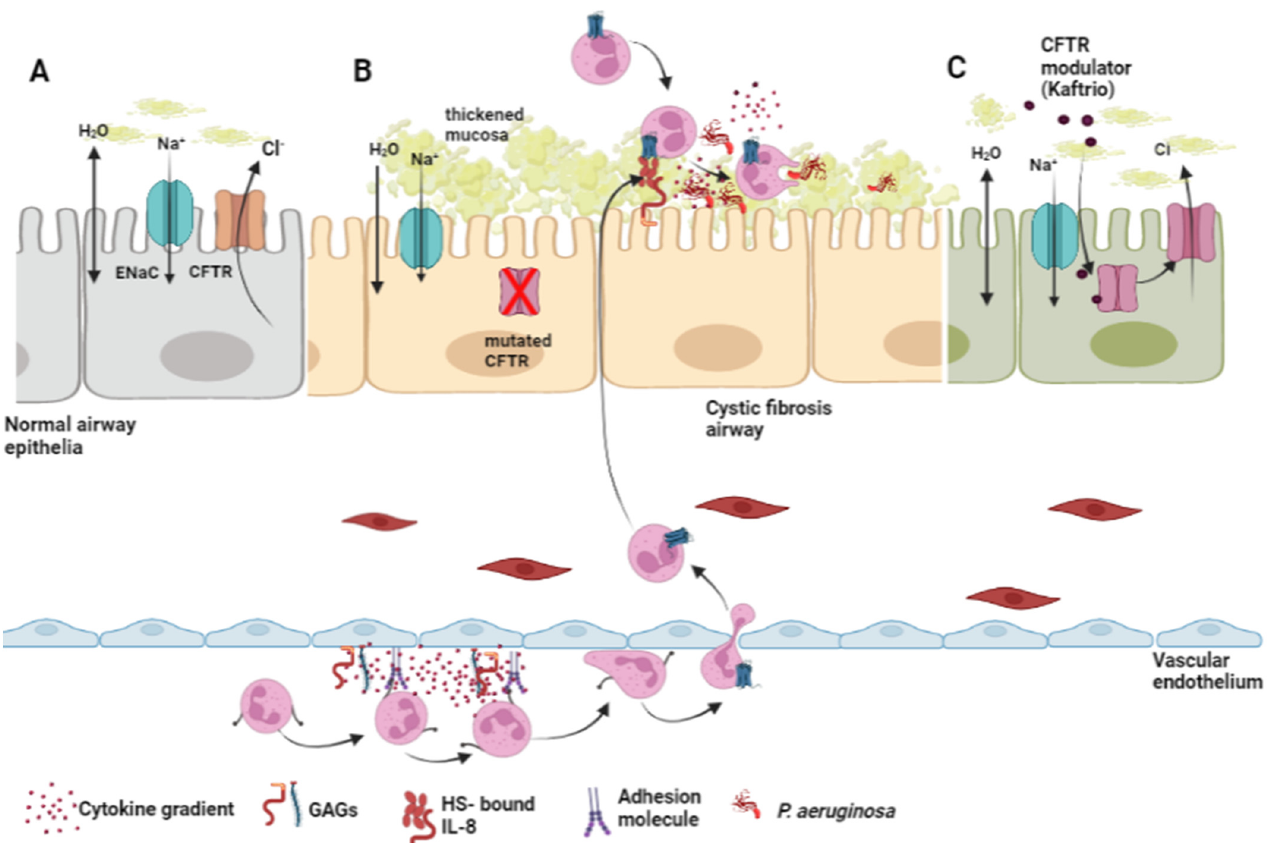
Figure 2. CF airways disease involves cytokine gradients created by glycosaminoglycans (GAG) which facilitate neutrophil extravasation in cystic fibrosis. ( A ) In healthy airway epithelial cells, fully functional CFTR plays a key role in regulating hydration of the airway surface liquid (ASL) layer. CFTR ion channels move chloride ions (Cl − ) from inside the cell to outside the cell, which attracts a layer of water, facilitating cilia movement and allowing passage of mucus up and out of the airways. ( B ) In patients with CF, due to a lack of CFTR function, Cl − secretion is impaired and Na + absorption through ENaC is upregulated resulting in dehydration of the ASL, thick mucus accumulating and bacterial colonization. Mucus viscosity is further increased by GAGs, which are increased in the CF airways and are also important for regulation of cytokine gradients. Neutrophils extravasate through endothelial cells of the blood vessels using cytokine gradients created by GAGs including chondroitin sulfate, heparin sulfate and hyaluronic acid. GAG-bound IL-8 facilitates the recruitment of neutrophils through binding of IL-8 to CXCR1. Recruited neutrophils fail to kill invading bacteria, and sustained recruitment leads to neutrophil dominated inflammation. ( C ) CF care includes small molecule drugs targeting the underlying CFTR protein defect, such as the CFTR modulator therapy Trikafta (Elexacaftor/Tezacaftor/Ivacaftor combination, Vertex Pharmaceuticals, also known as Kaftrio), which demonstrates significant improvement in lung function.